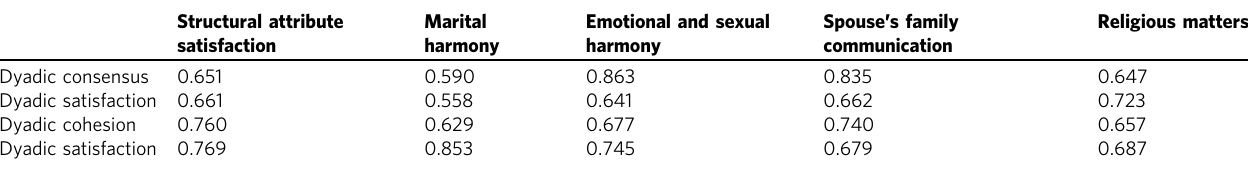
Table 5 Correlation between WQMCF factors and DAS subscales ( n =